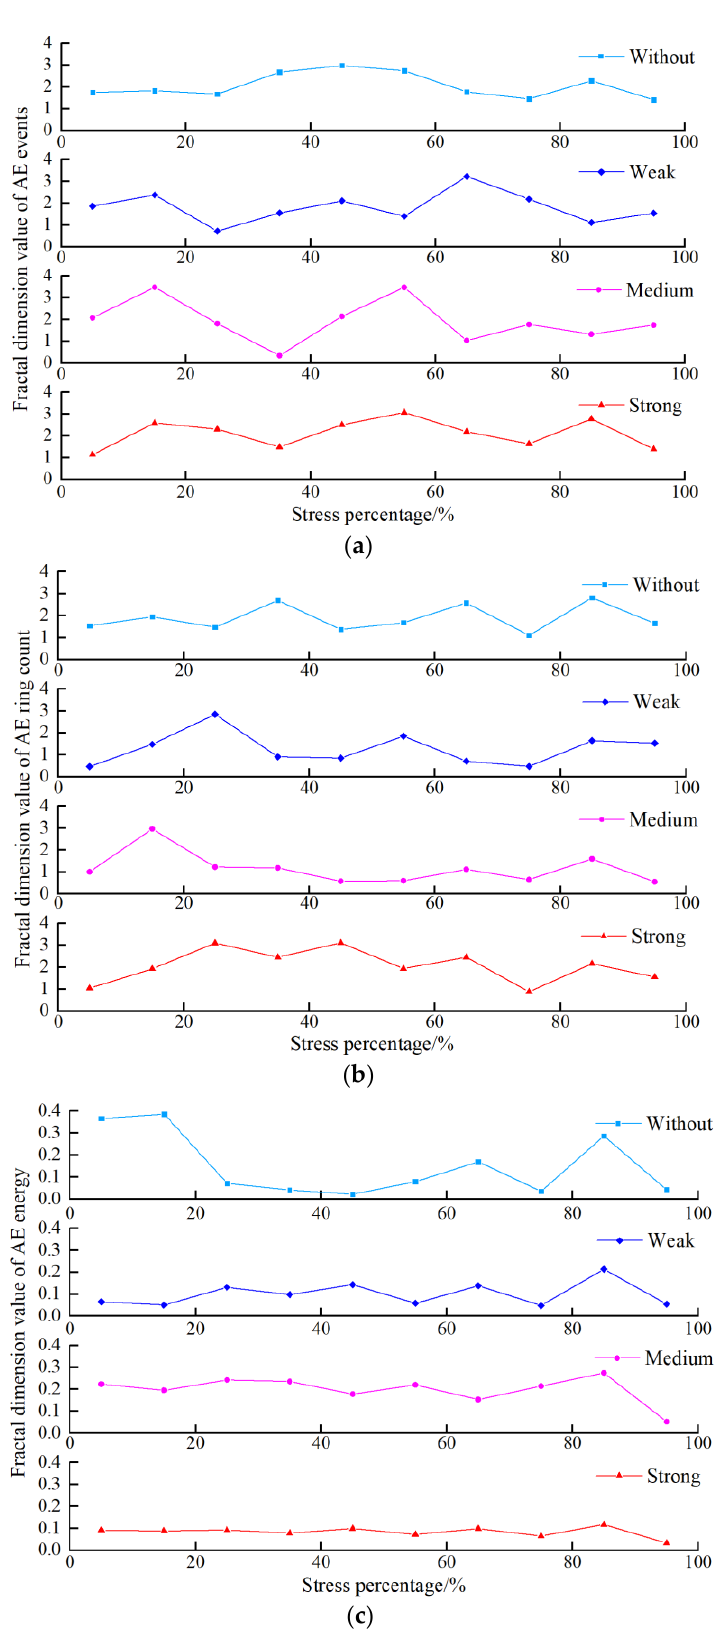
Figure 10. Double logarithmic relationship of AE energy of the limestone. ( a ) The limestone without a rockburst tendency; ( b ) the limestone with a weak rockburst tendency; ( c ) the limestone with a medium rockburst tendency; and ( d ) the limestone with a strong rockburst tendency.